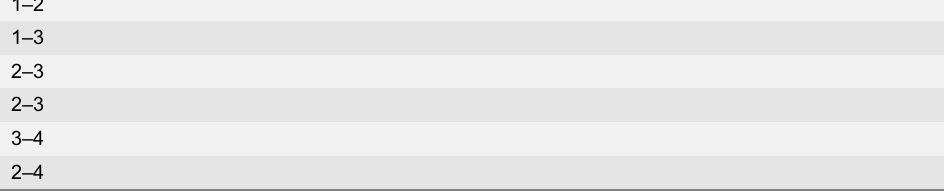
Table 3. Example of a master-list that includes all extracted connections for all countries and all